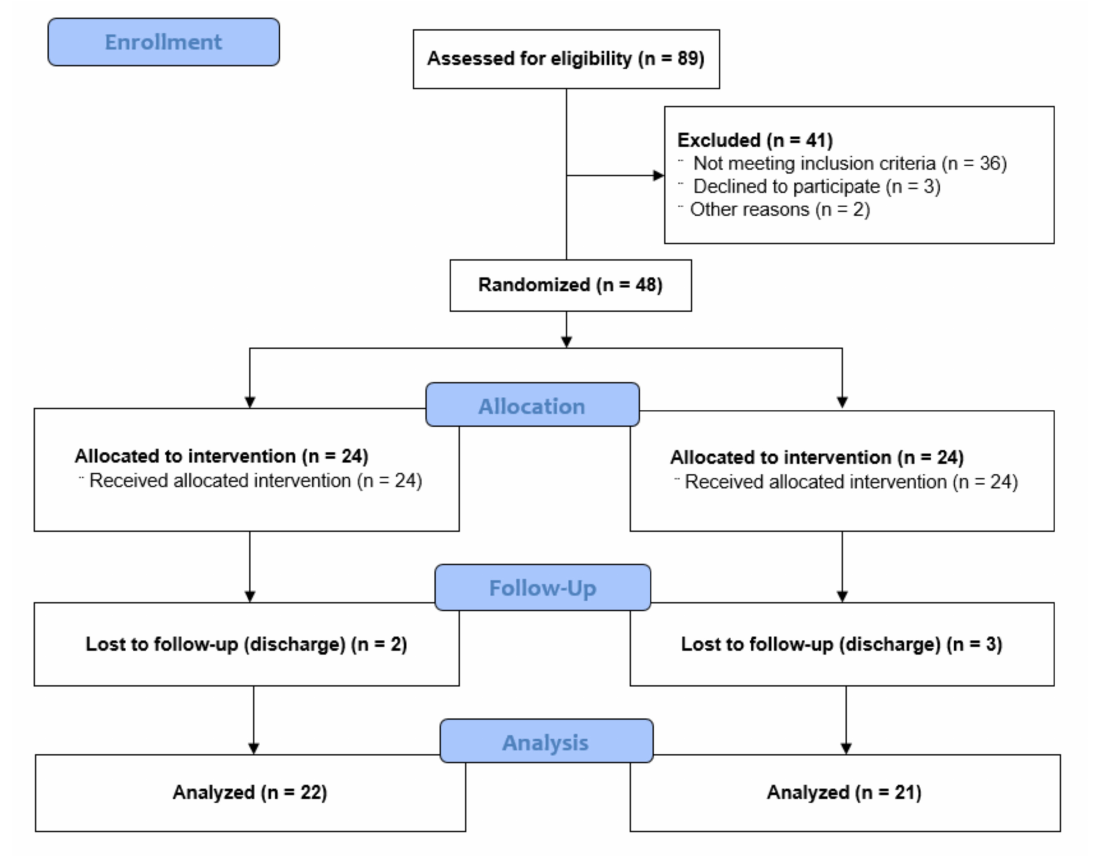
Figure 1. Flow diagram of the participants.